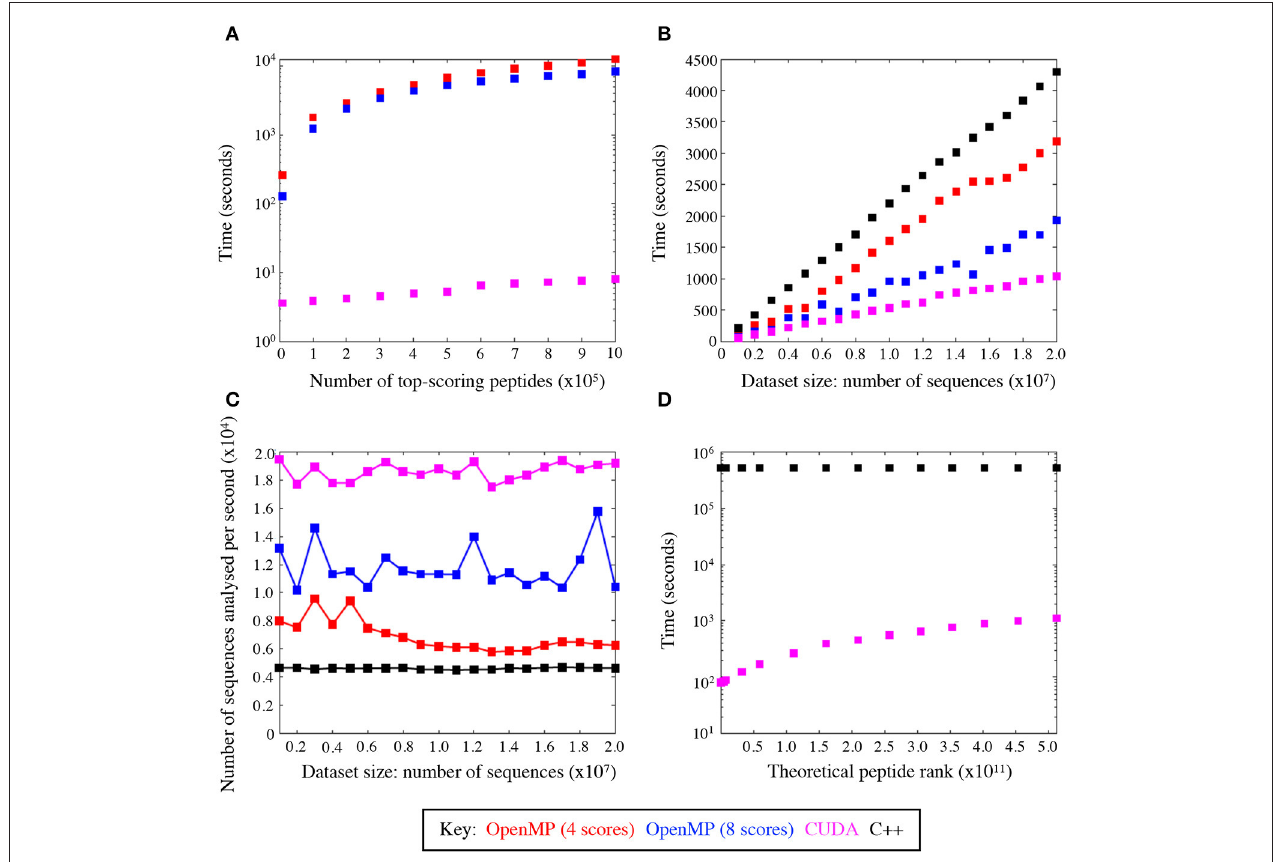
FIGURE 4 | GPU speed-up compared with C ++ and OpenMP. (A) Average total runtime of the peptide scoring algorithm, where the number of returned top-scoring peptides varied from 100 to 10 6 . (B) Average speed-up across C ++ and OpenMP implementations, where the size of the dataset to scan varied from 10 6 to 2 × 10 7 sequences. (C) The average rate at which sequences were analysed with CUDA is superior to all the other implementations. (D) Average speed-up by the CUDA and C ++ code to rank theoretical peptides ordered from the highest to the lowest agonist likelihood